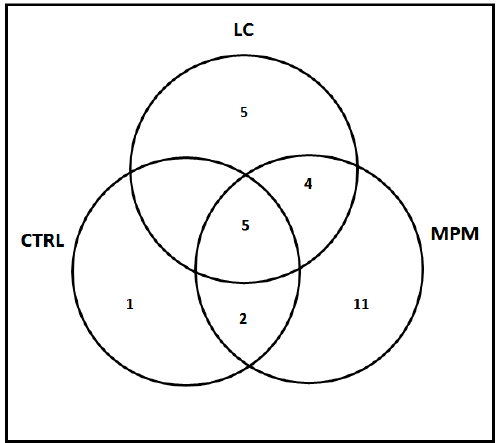
Figure 1. Venn diagram of the exclusive and shared (5) enriched pathways in CTRL (1), MPM (11) and LC (5) populations.